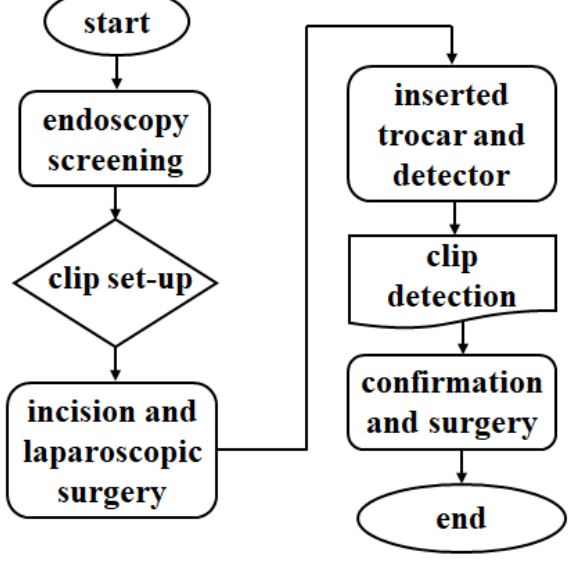
Figure 2. Flowchart of clip detection and tumor localization.